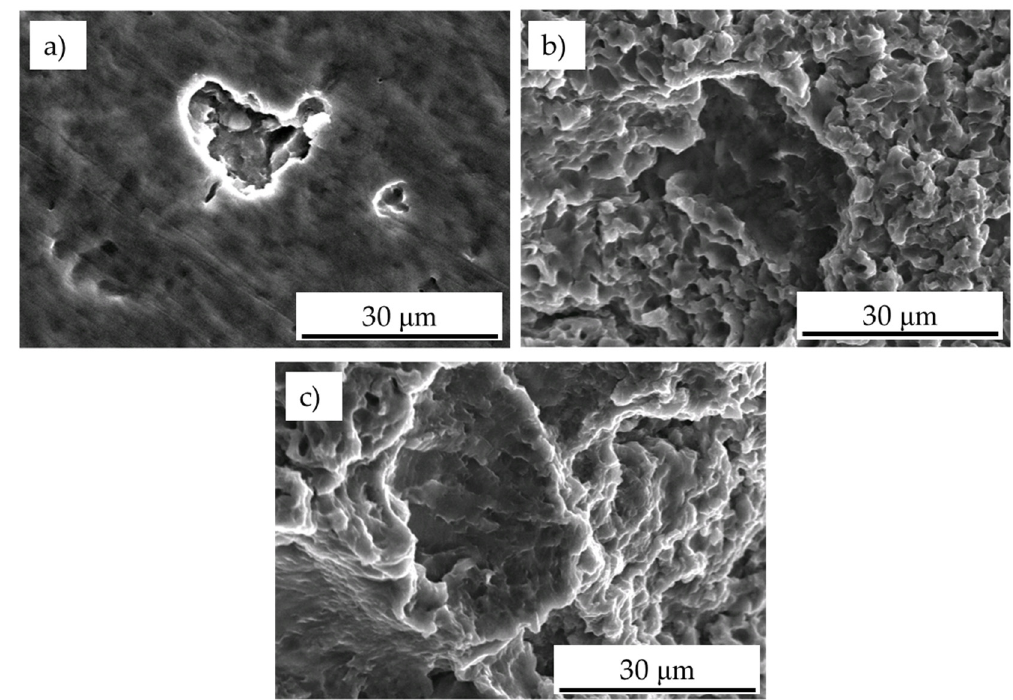
Figure 12. Detail of pits/cavities on eroded surface after ( a ) 8 min, ( b ) 60 min, and ( c ) 8 h of cavitation exposure.